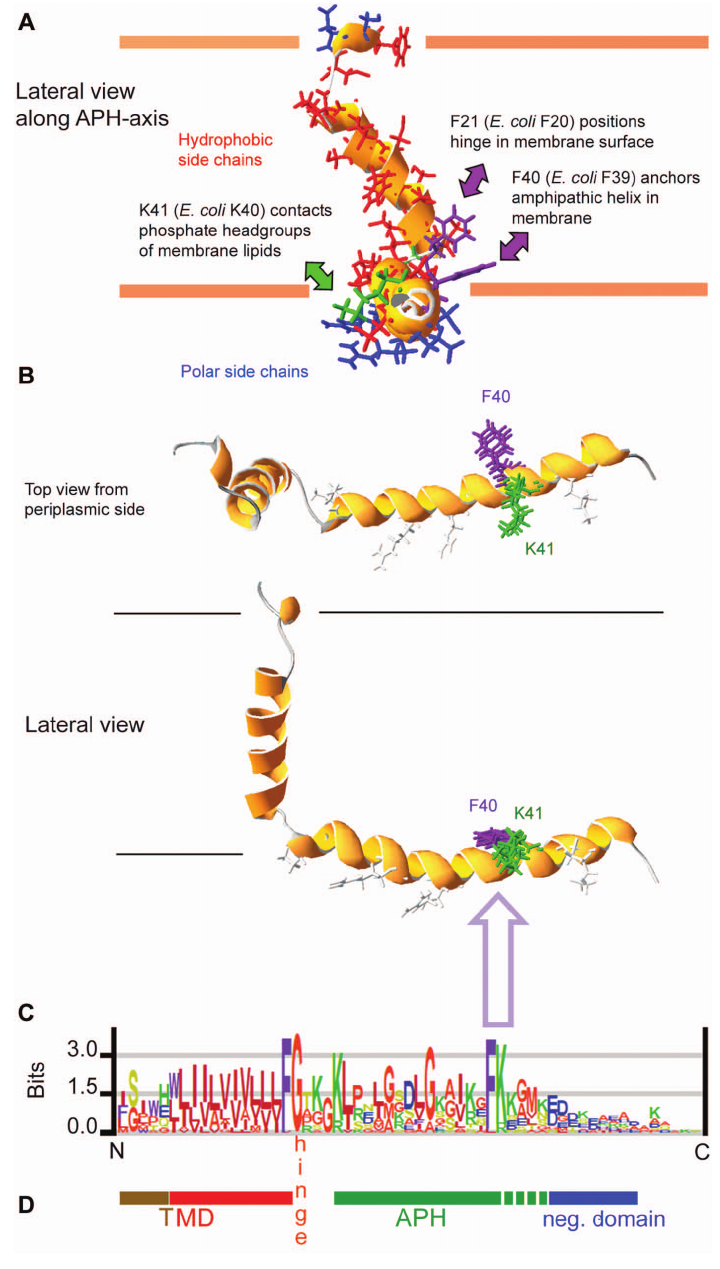
Figure 3 Implications based on the high-resolution structure of TatA. (A–C) Structural model of B. subtilis TatA and its proposed positioning relative to the membrane. The view perspectives are described on d the left and were generated using the PDB-file 2L16 and the program SPDB-viewer (187). (A) Model including side chains of the TMD and the amphipathic helix, and their orientations relative to the membrane surface. The structure was oriented by positioning the amphipathic helix, which faces its polar side chains (blue) toward the aqueous phase and its hydrophobic side chains (red) toward the membrane, and the TMD, which shows a slightly tilted membrane-spanning orientation. The F of the FG motif in the hinge and both residues of the FK motif at the end of the amphipathic helix are highlighted (F in purple, K in green). The C-terminal region of the FK motif is removed for clarity reasons. (B) Models showing the positioning of the FK motif in the amphipathic helix. Note that the region of the amphipathic helix that follows the FK motif is more flexible and not predicted to be an amphipathic helix, and might not be formed in the absence of detergent. (C) Sequence logo of the functionally important N-terminal TatA region generated with the program enoLOGOS (188), based on 48 aligned TatA sequences from a -, b -, g -, d -, ´ -proteobacteria; low-GC Gram-positive bacteria; and actinobacteria. (D) Schematic presentation of the TatA regions important for Tat transport. The N-terminal TMD is indicated in brown and red, with brown in the region of lower conservation and lower hydrophobicity and red in the region of the hydrophobic a -helix. The amphipathic helix is indicated in green. Interruptions indicate the less conserved and less rigid region on the C-terminal side of the FK motif. The less conserved negative region is indicated in